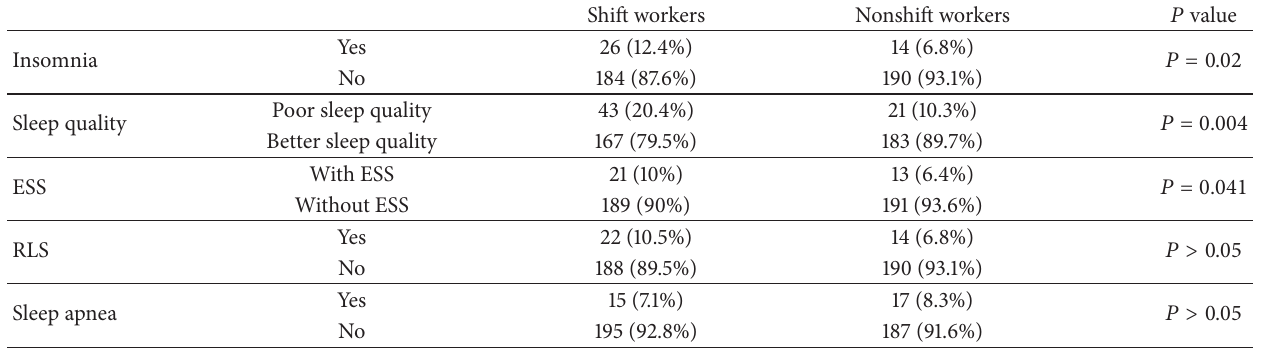
Table 2: Prevalence of different types of sleep disorders in two groups of shift workers and nonshift workers.